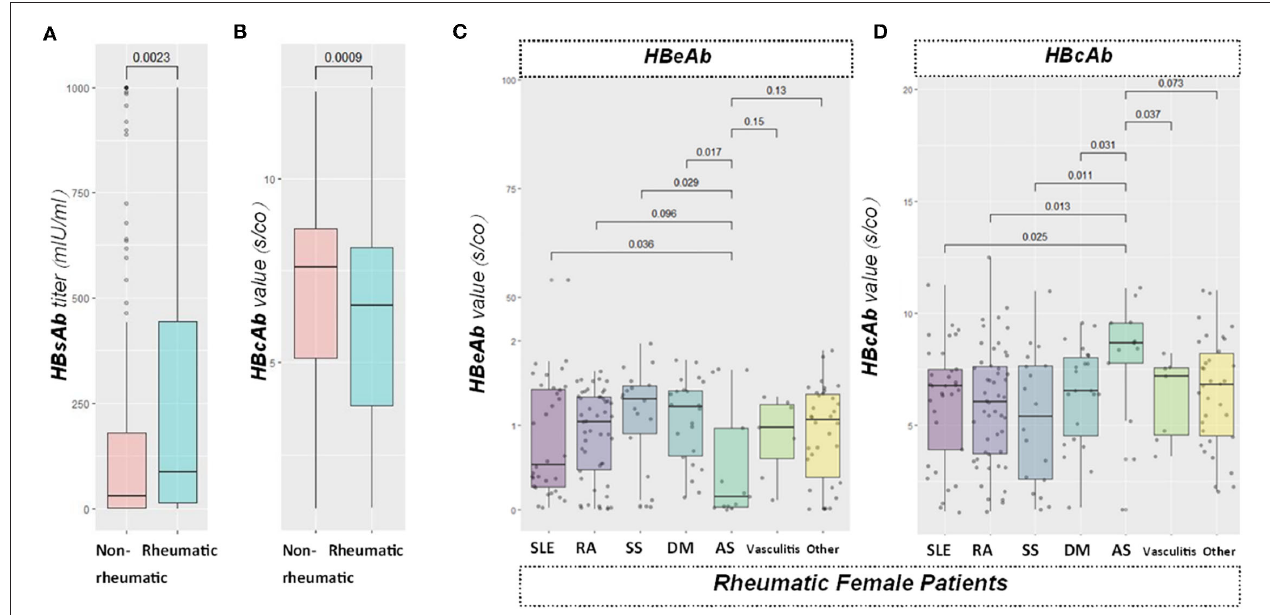
FIGURE 4 | Viral specific antibody level comparisons. From left to right: (A) boxplot showed HBsAb value between the rheumatic and non-rheumatic groups. (B) boxplot showed HBcAb signal over cutoff ratio (s/co) value in patients from the two groups; (C,D) boxplots sequentially showed HBeAb and HBcAb antibodies levels among different rheumatic diseases. HBeAb values were significantly different between ankylosing spondylitis (AS) with systemic lupus erythematosus (SLE), Sjögren’s syndrome (SS), or dermatomyositis (DM) group in the female subgroup, while no significance was found in the male group. Moreover, a significantly higher value of HBcAb in patients with AS than SLE, RA, SS, DM, or vasculitis in the female subgroup were also found, while no significance was found in the male